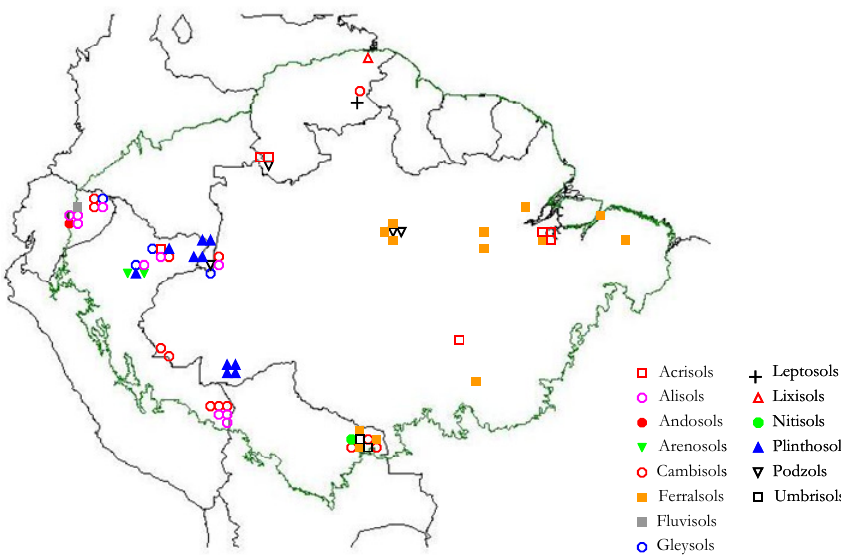
Fig. 1. Distribution of identified soil types across